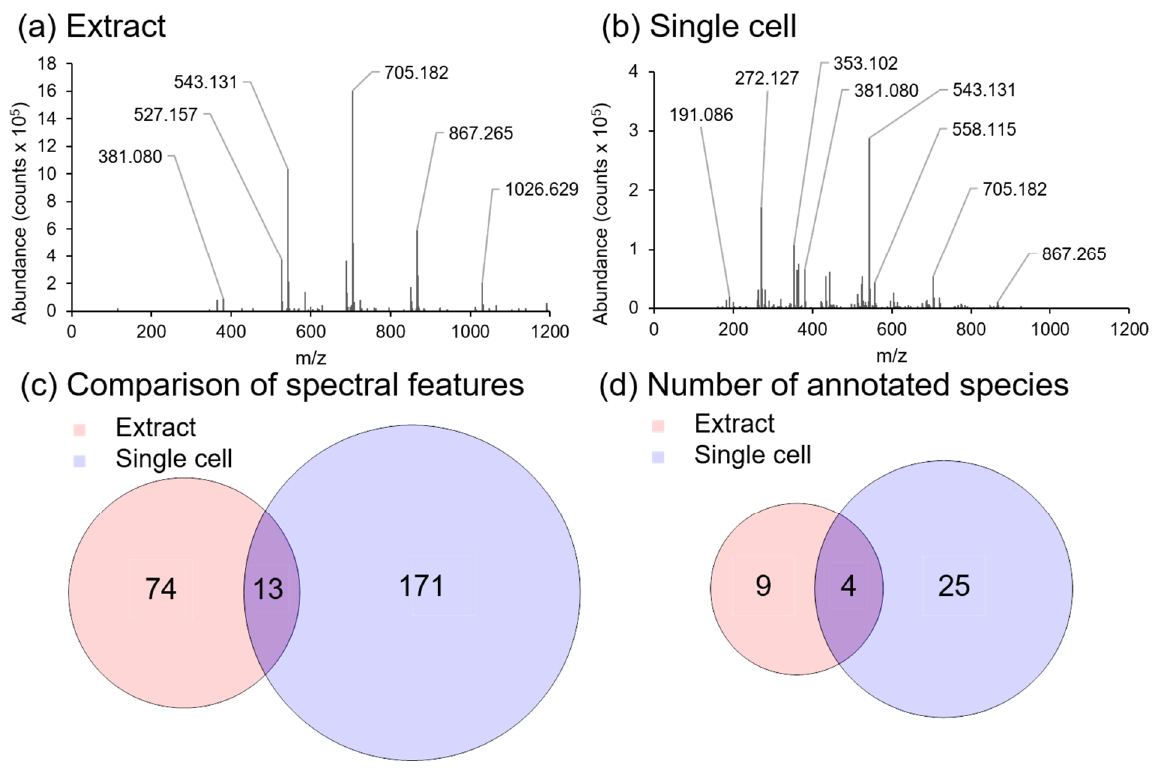
Figure 5. Spectral comparison of an aqueous extract from homogenized A. Cepa , and a single A. Cepa epidermal cell with LAESI-MS. ( a ) Positive ion spectrum acquired by ablation of a 3 µl droplet of an A. Cepa tissue extract on a parafilm coated microscope slide with LAESI-MS, and ( b ) positive ion spectrum of an A. Cepa single epidermal cell. ( c ) Venn diagram showing the number of unique and shared spectral features between the aqueous extract and the single cell spectra. ( d ) Venn diagram showing the number of unique and shared annotated species between the aqueous extract and the single cell spectra.